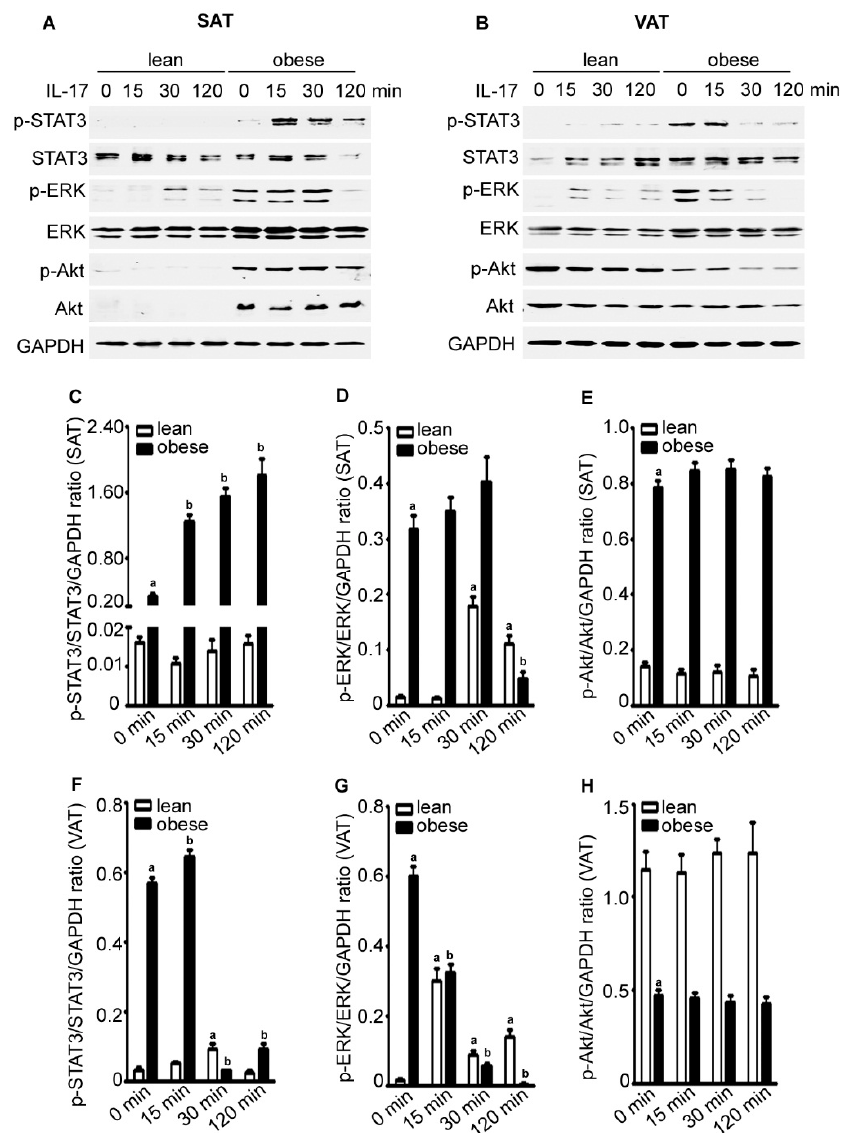
Figure 4. IL-17A differentially activates signaling pathways in the adipose tissues of lean and obese mice. ( A , B ) Adipose tissues were cultured in serum-free DMEM and treated without (time zero) or with 20 ng/mL IL-17A for 15, 30, and 120 min; proteins were assessed by Western blot analysis; GAPDH was probed for loading control; ( C – E ) Quantification of the Western blot results in ( A ) and ( F – H ) quantification of the Western blot results in ( B ); data are mean ± standard error of the mean (SEM) of three independent experiments; a p < 0.05, compared to the untreated group of the lean mice; b p < 0.05, compared to the untreated group of the obese mice.